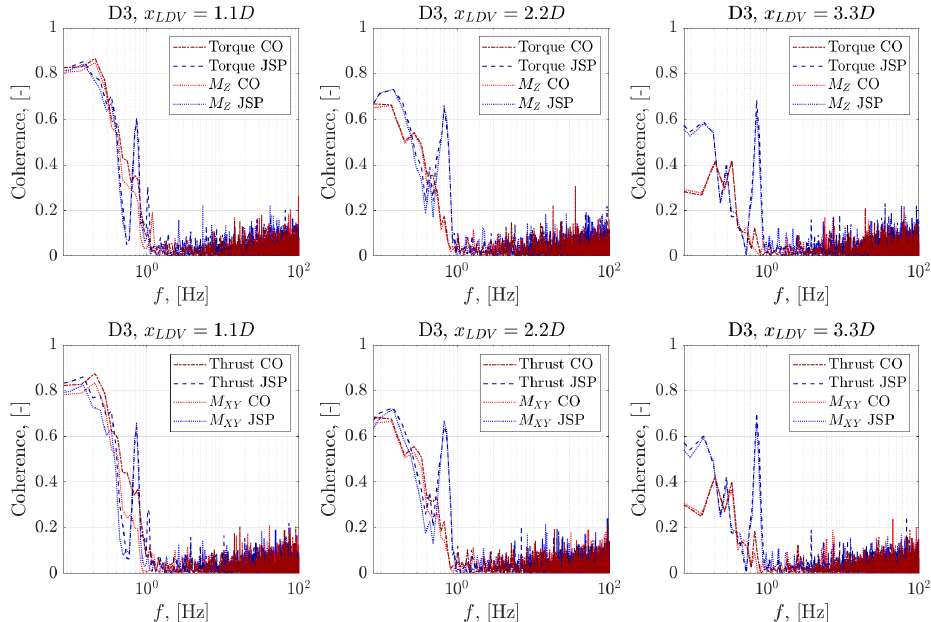
Figure 19. Spectral cohesion between rotor and blade loading quantities and the fluid velocity measurements taken at differing upstream positions for the D3 case. The upper charts show torque- wise loading and the lower charts show thrust-wise